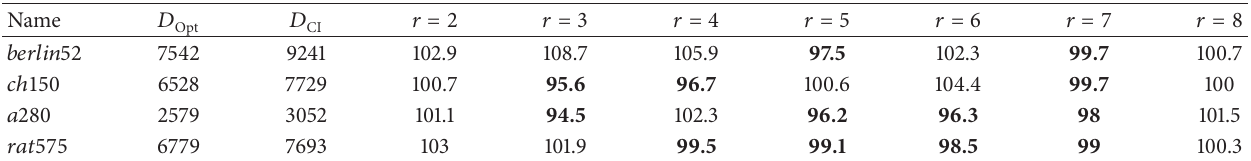
Table 1: The comparison of tour costs obtained by CI and by Algorithm 3 for different TSPLIB [19] instances; 𝐷 isthecostoftheCI-tour;theremainingcolumnspresentthevaluesof 𝐷(𝛽)/𝐷 solution; 𝐷 CI with the correspondent 𝑟 and 𝑚 ≡ 10